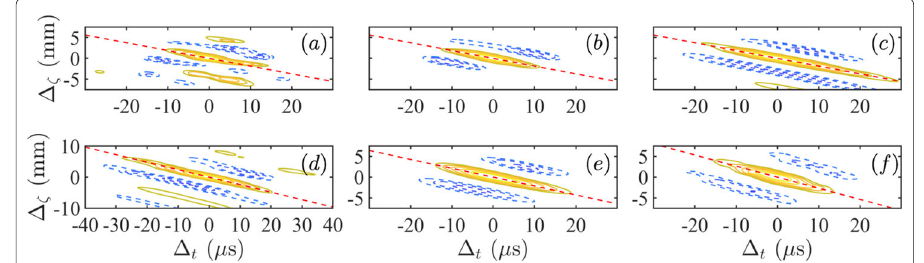
(cid:2) (cid:3) Fig. 17 C pp 0, (cid:7) ζ , (cid:7) t for low-frequency wall pressure at probe points in Group 2. Contour levels are the same as in Fig. 16. The slopes of the dashed lines are -0.175 q ∞ in a - c , -0.225 q ∞ in d , -0.2 q ∞ in e and -0.25 q ∞ in